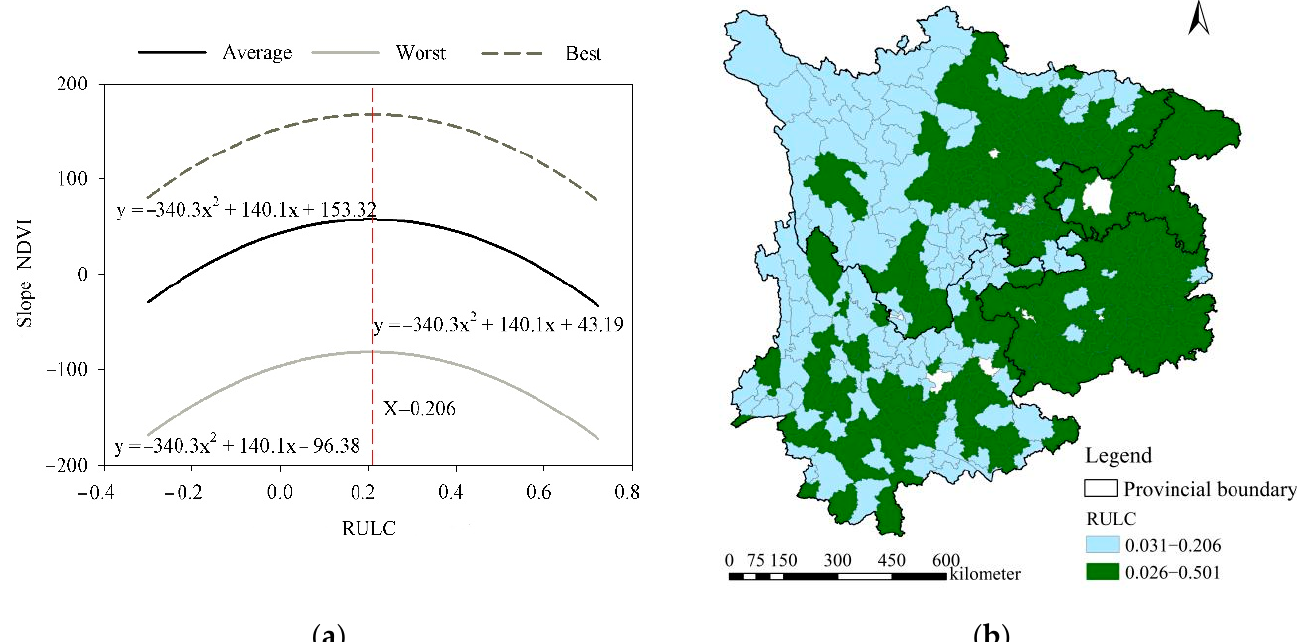
Figure 7. ( a ) The Inverted-U-shaped relationship between the RULC and the Slope − NDVI; ( b ) The RULC in the mountain- ous areas of southwest China.